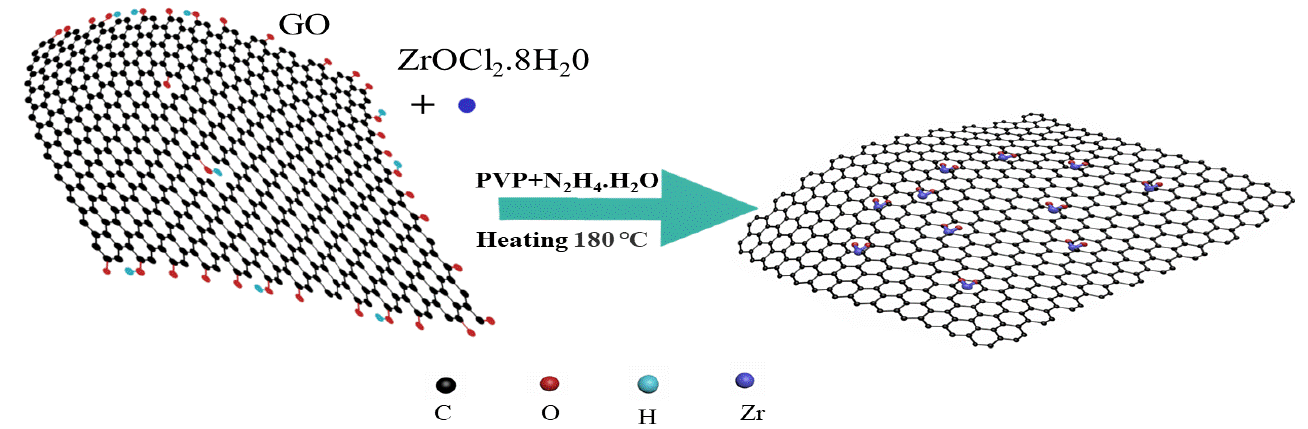
Figure 1. Schematic diagram of the ZrO 2 /RGO composite nanostructure.